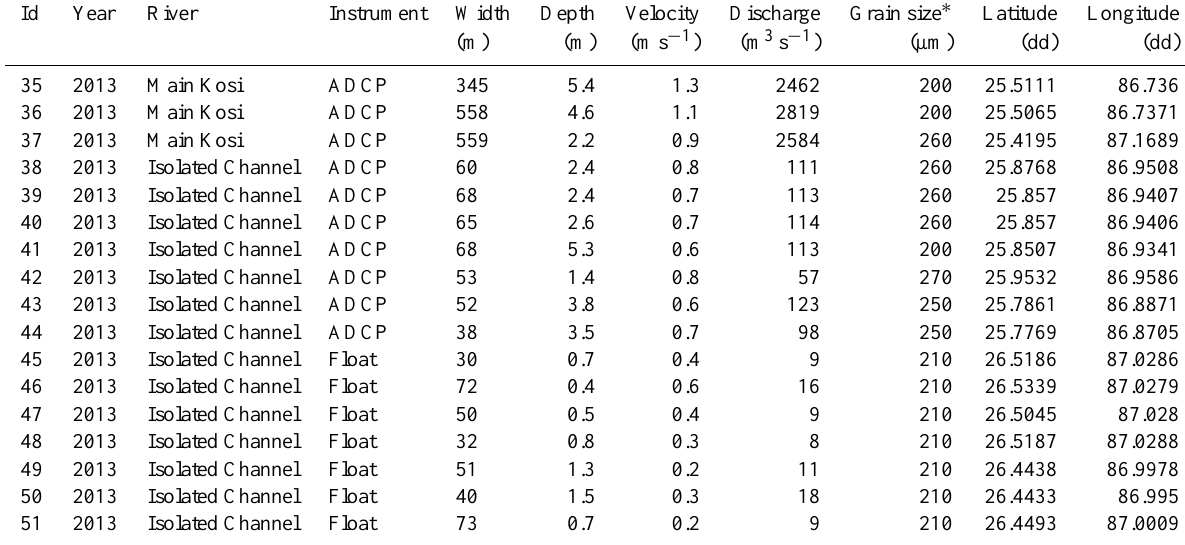
Table 3. Hydraulic geometry and water discharge data measured on the single thread of meandering channels. Id